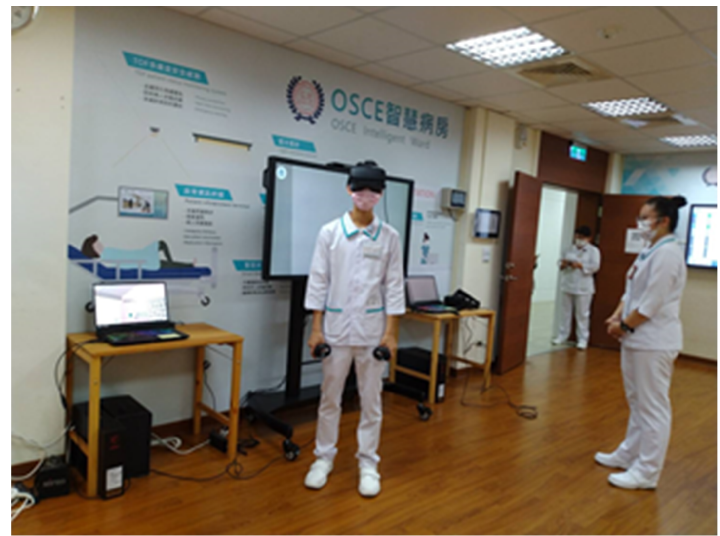
Figure 4. A student practicing using the IVR system. Table 1. Research process.